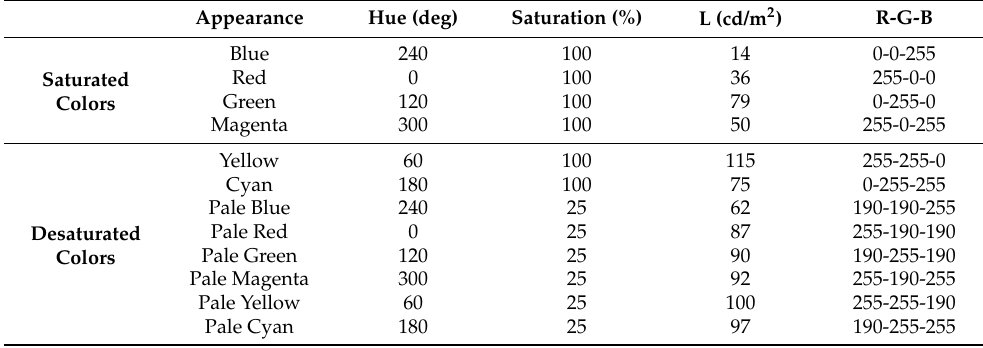
Figure 2. Images used in the choice response time experiment. Shape pairs displaying perfect geometric vertical mirror symmetry within and between shapes of any pair were presented to human individuals in random order. Variations in the symmetry of things in a thing of the shapes in a pair were generated by giving the local shape elements variable local hues or contrasts, producing five levels of increasing variability between the two shapes. This resulted in five arbitrary, experimentally operational levels of local shade variability producing perceptual system uncertainty from lowest ( 1 ) to highest ( 5 ). In ( 2 ), ( 3 ) and ( 5 ). The locus of variability between left and right was counterbalanced between experimental sessions. Table 1. Physical color parameters and photometric luminance (L in candela per square meter) generating variability of appearance in the experimental